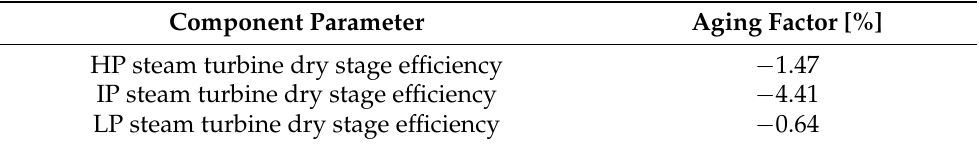
Table 3. Adjustment factors applied to steam turbine efficiencies to implement performance degrada- tion caused by aging.